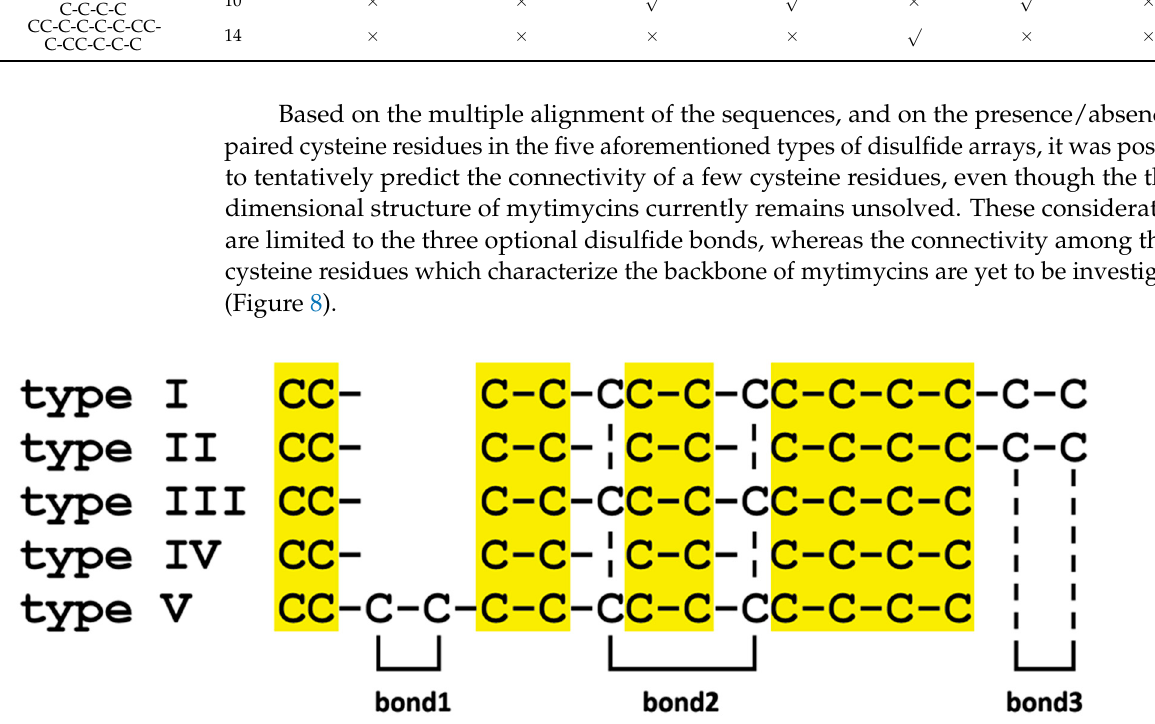
Table 1. Taxonomic distribution of the mytimycin cysteine arrays observed in Mytilida. For M. galloprovincialis , the type